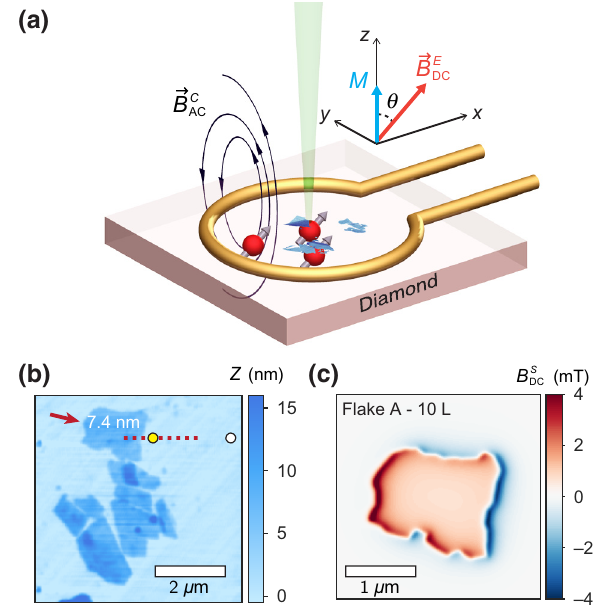
FIG. 1. Experimental overview. (a) CrBr 3 flakes (blue) are exfoliated onto a diamond chip containing a shallow ensemble of for exciting NV centers (red). A coil delivers both the ac field (cid:2) B C ac the magnetic dynamics of the ferromagnet and the gigahertz- frequency pulses to manipulate the NV center spin. The static is aligned along the NV center axis, while the bias field (cid:2) B E dc easy axis for the magnetization M is along the out-of-plane, z direction. (b) AFM image of Flake A (arrow), ten layers thick. Measurements are primarily taken outside the flake’s right edge (yellow dot) and are referenced to the background signal far away from the flake (e.g., white dot). (c) Simulated stray field map for is the Flake A, assuming a NV center depth of 60 nm. Here B S dc component of the flake’s stray field parallel to the NV center